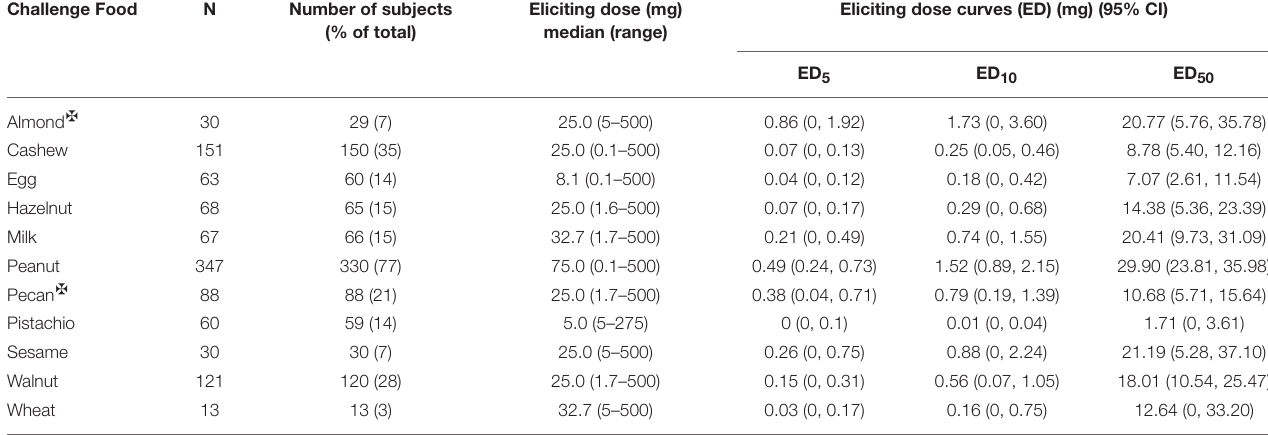
TABLE 3 | Eliciting dose (ED) thresholds by